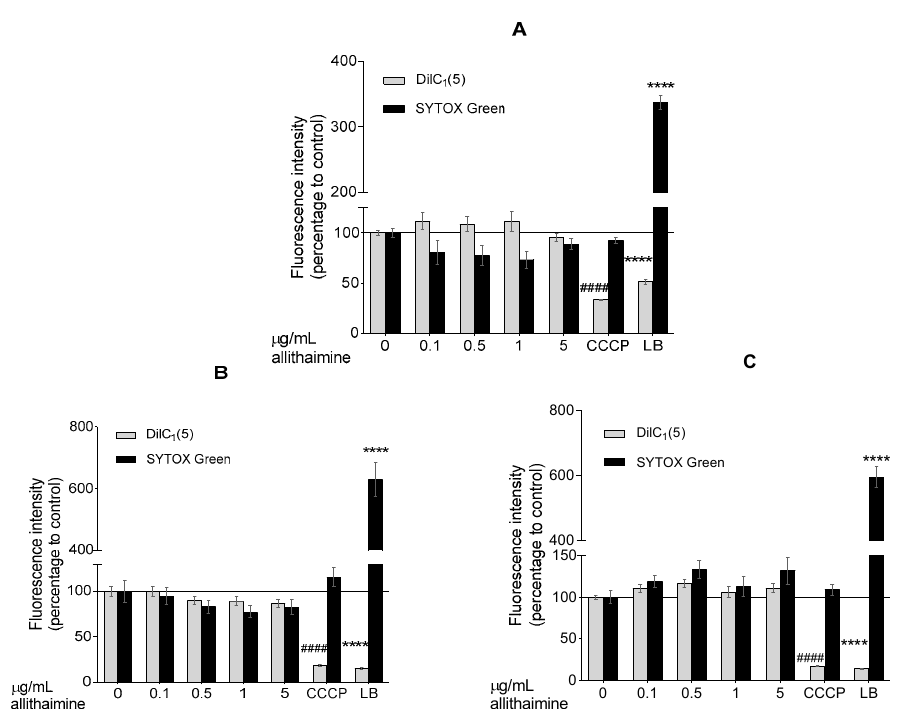
Figure 3. Fluorescent DilC 1 (5) and SYTOX Green labeling. Effect of allithiamine on apoptosis and necrosis after 24 ( A ), 48 ( B ), or 72 ( C ) h. Results (intensity of fluorescence) are expressed in the percentage of the control(0 µ g / mLallithiamine; 100%isrepresentedbythesolidlines). Apoptosisisindicatedbyadecreasein fluorescence of DilC 1 (5), and necrosis is indicated by an increase in fluorescence of SYTOX Green. Data are expressed as the mean ± SEM of three individual experiments. Two additional experiments yielded similar results. **** and #### mark significant ( p < 0.0001 in both cases) differences compared with the control group (0 µ g / mL allithiamine). CCCP: carbonyl cyanide m-chlorophenyl hydrazone (positive control for apoptosis); LB: lysis buffer (positive control for necrosis). SYTOX Green: non-permeable fluorescent